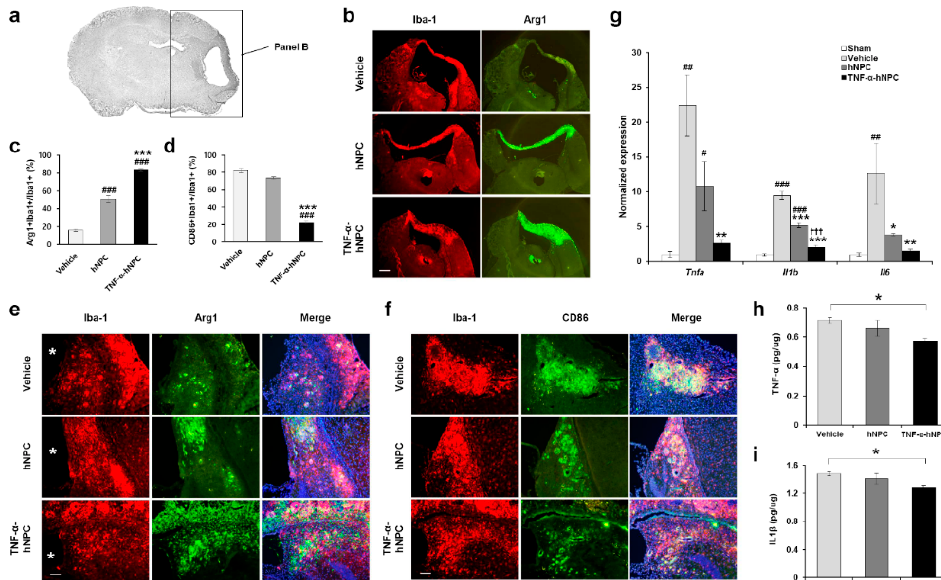
Figure 5. TNF- α -pretreated hNPCs altered the ratio of M1 / M2 phenotype of microglia and decreased proinflammatory cytokines in HI brain injury. ( a ) A low-magnification view of HI-injured brain. The black box represents the ipsilateral hemisphere of HI-injured brain at 2 weeks post-transplant. ( b ) The ipsilateral hemisphere co-stained for Arg1 (M2 marker, green) and Iba-1 (red). Scale bar, 50 μ m. ( c ) Quantification of the percentage of Arg1+/Iba-1+ cells (n = 3 per group). ( d ) Quantification of the percentage of CD86+/Iba-1+ cells (n = 3 per group). ( e ) A higher magnification image of Arg1/Iba1-positive cells. An asterisk indicates the infarct area. Scale bar, 50 μ m. ( f ) Representative images of Iba1 (red) and CD86 (green) immunostaining 2 weeks after HI brain injury. Scale bar, 50 μ m. ### p < 0.001 vs. vehicle, *** p < 0.001 vs. hNPCs. ( g – i ) Effects of TNF- α -pretreated hNPCs on modulation of inflammatory responses at 1 week post-transplant. ( g ) qRT-PCR for relative expression levels of mouse cytokine mRNA in the ipsilateral hemisphere of HI brain (n = 3–5 per group). # p < 0.05, ## p < 0.01, ### p < 0.001 vs. Sham; * p < 0.05, ** p < 0.01, *** p < 0.001 vs. vehicle; ††† p < 0.001 vs. hNPC. ( h , i ) ELISA for mouse TNF- α ( h ) and IL-1 β ( i ) proteins in the ipsilateral hemisphere of HI